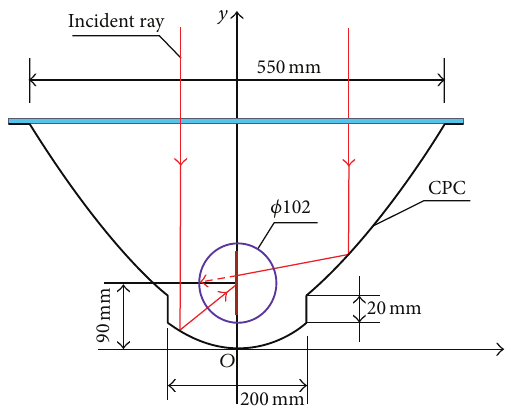
Figure 1: Multisurface groove concentrator focusing principle and geometry dimension.